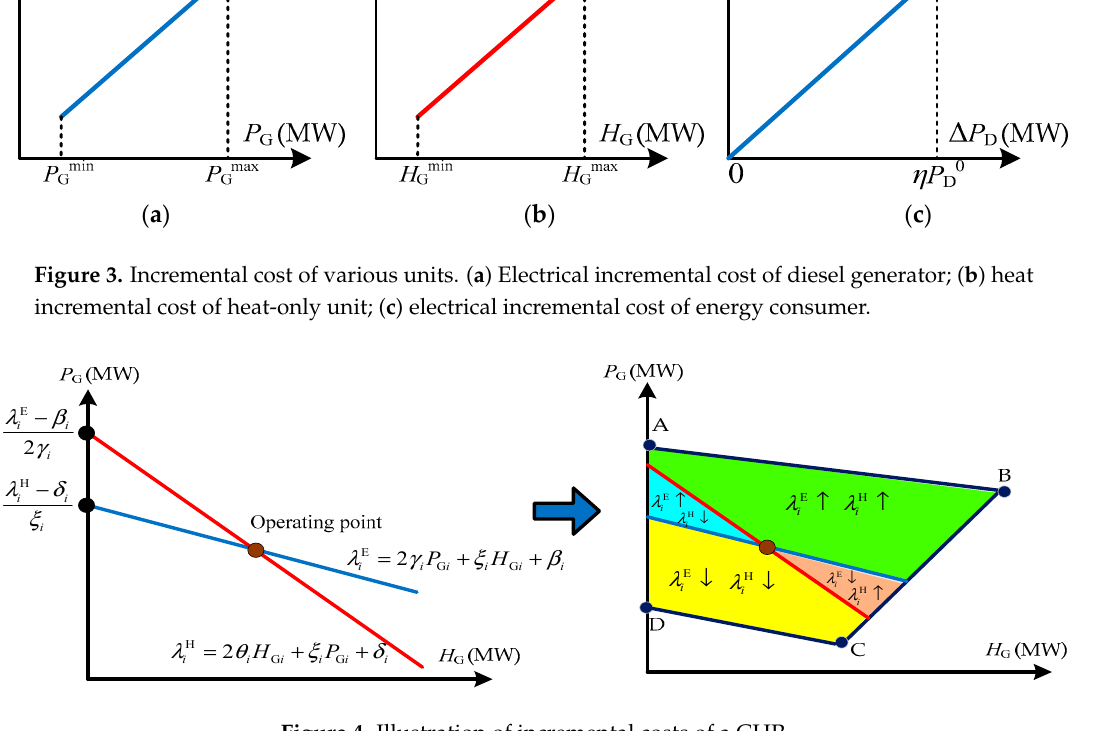
Figure 4. Illustration of incremental costs of a CHP.